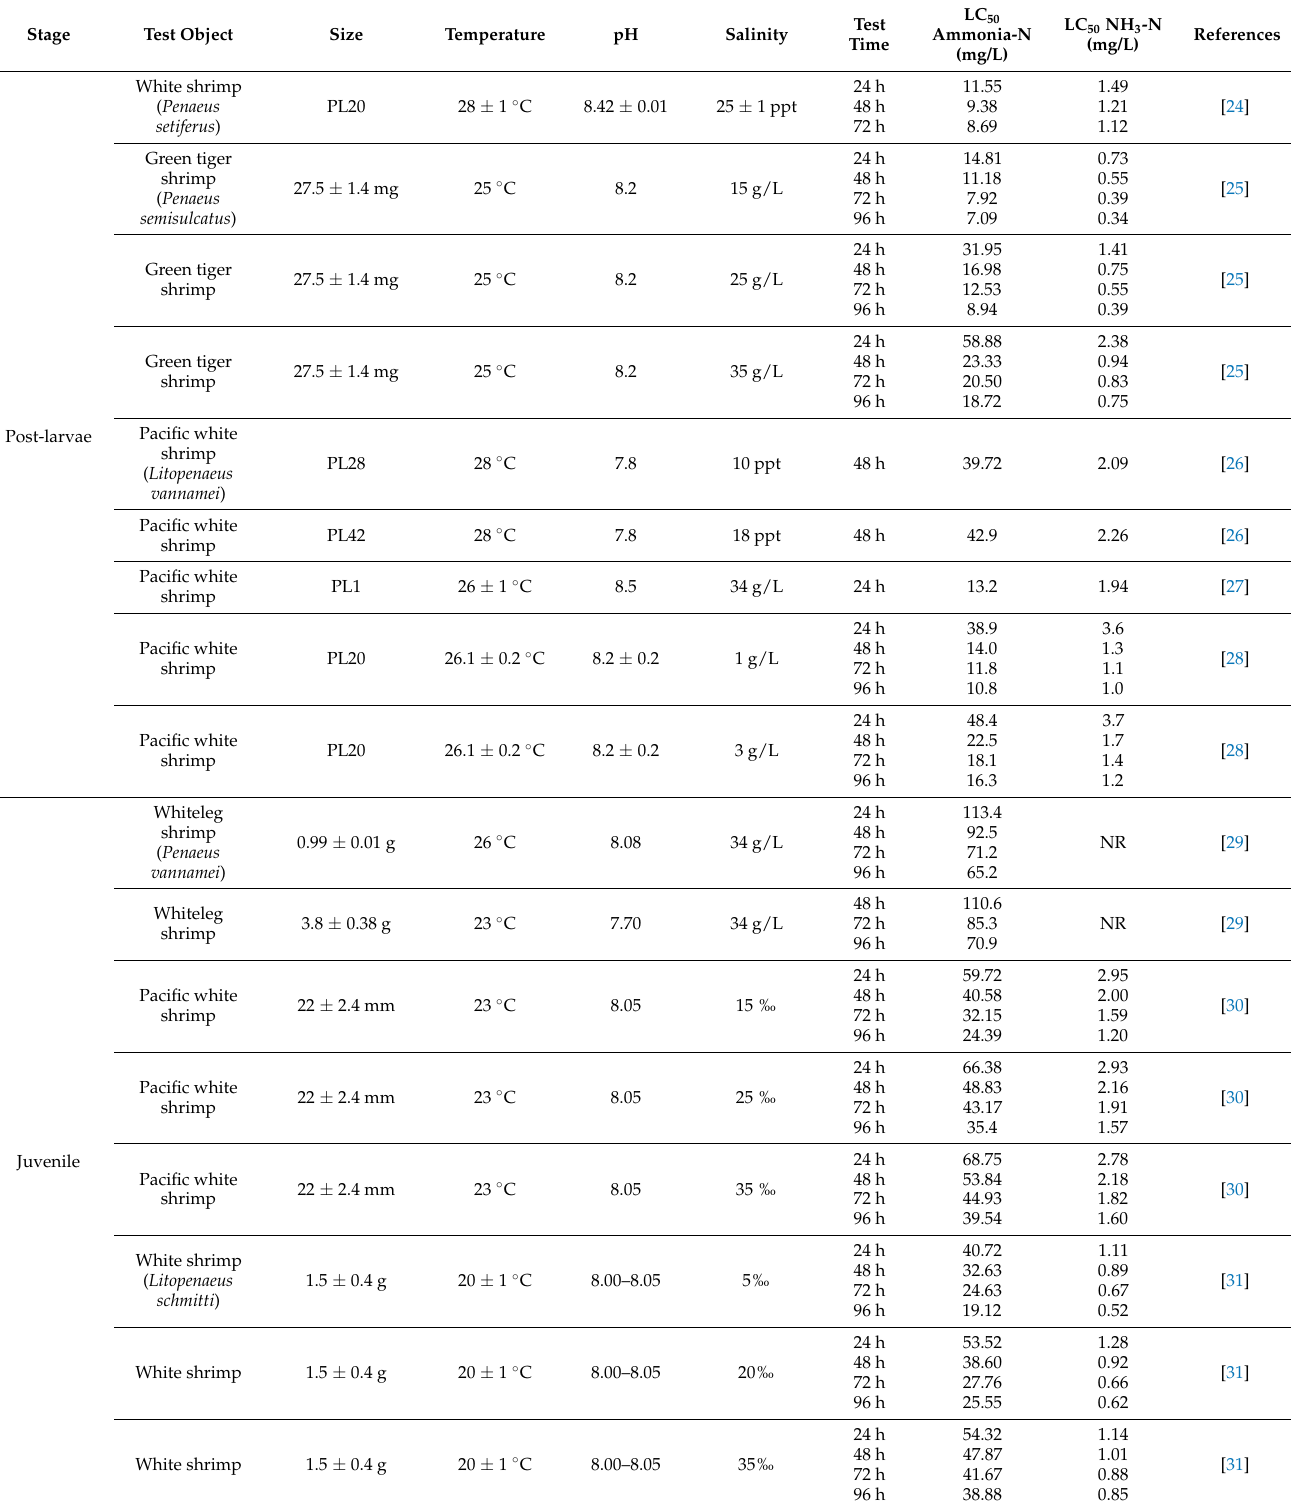
Table 1. Summary of acute toxicity of ammonia-N in